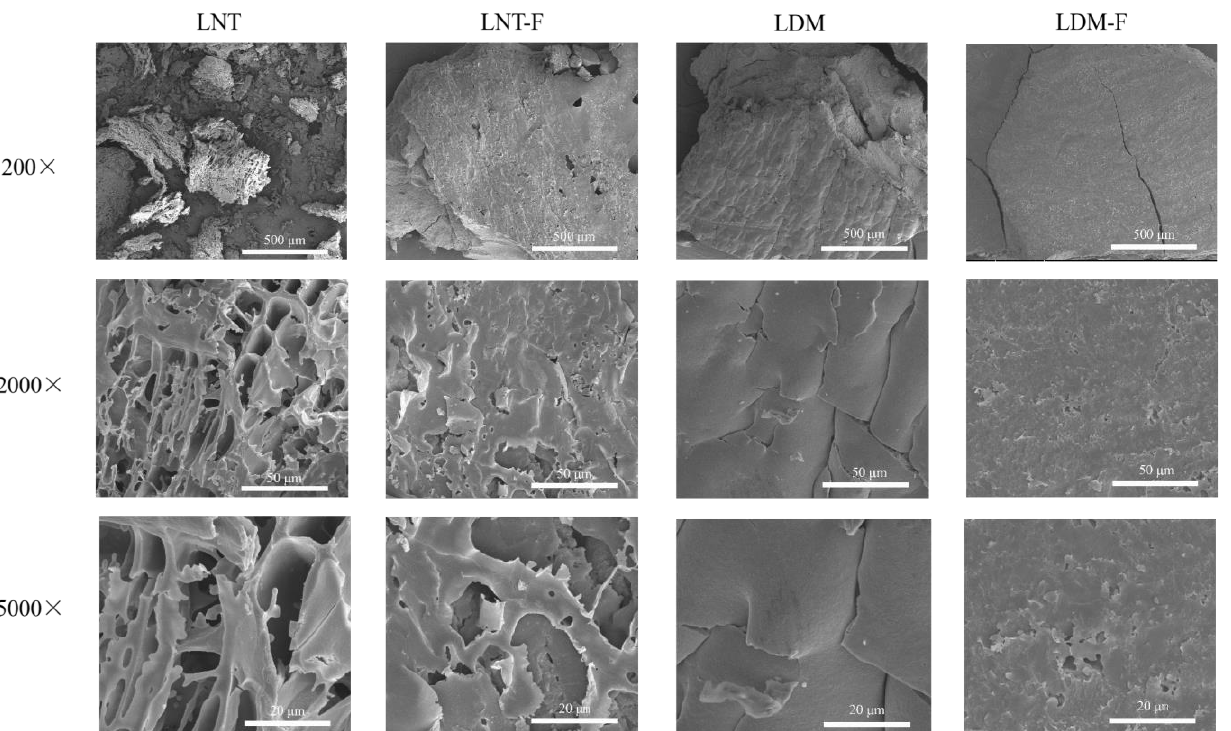
Figure 5. Scanning electron micrographs of samples. Lentinula edodes powder (LNT) and fermented LNT (LNT-F), soybean powder (LDM) and fermented LDM (LDM-F).